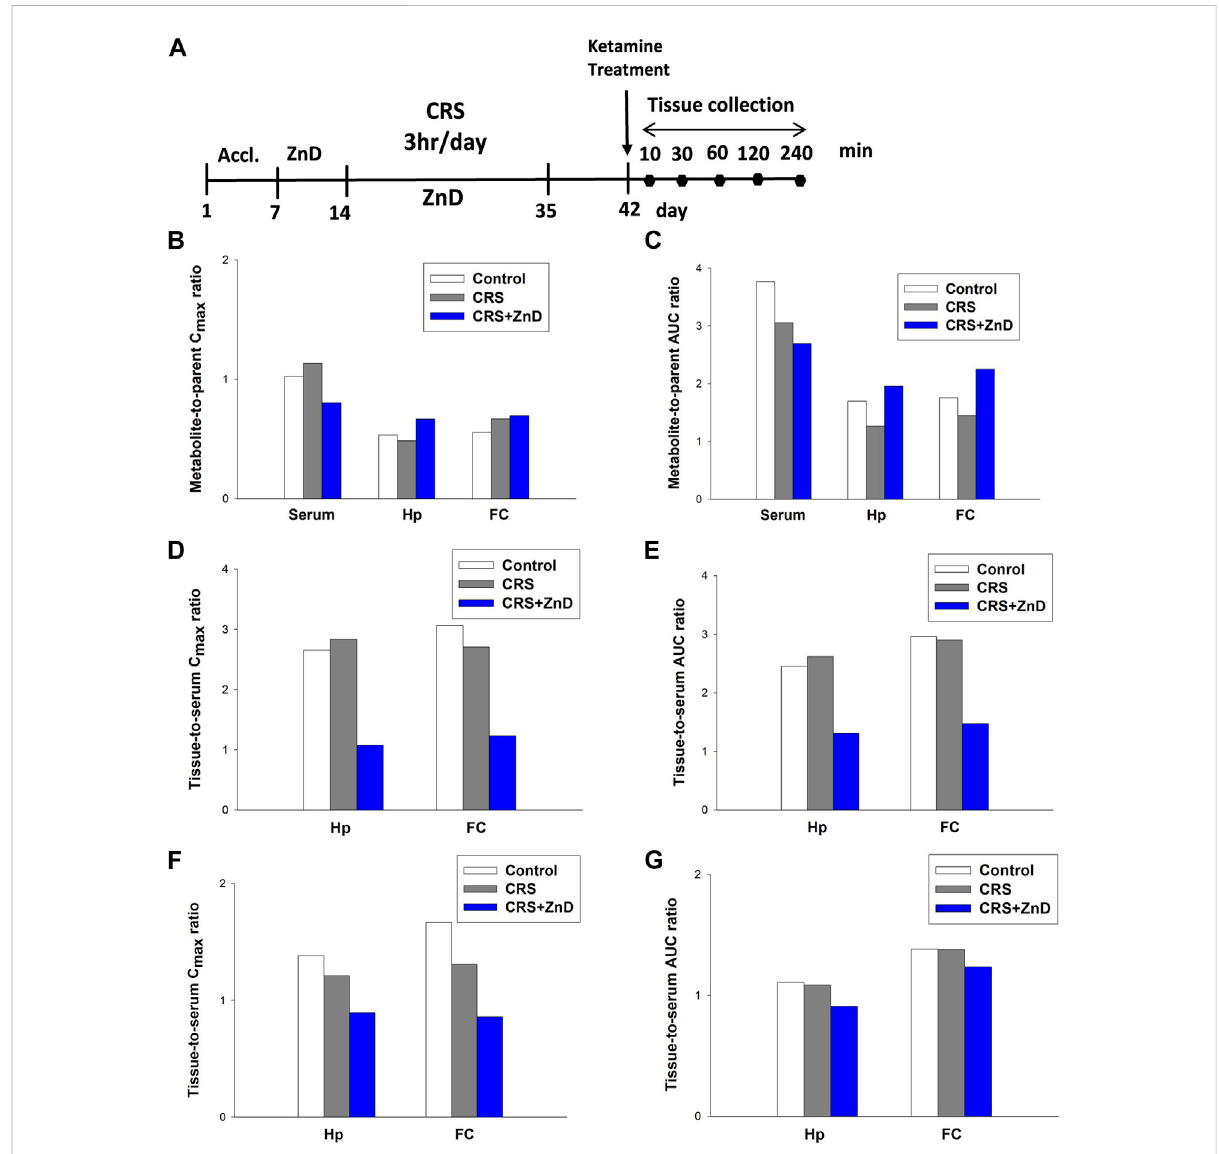
FIGURE 8 (A) Experimental schedule of drug treatment. (B,C) Metabolite-to-parent ratios of maximum concentrations (C max ; left panel) and areas under thecurves(AUCs;rightpanel)inthecontrolandstudygroups. (D,E) Tissue-to-serumratiosofC max (leftpanel)andAUCs(rightpanel)forketaminein the control and study groups. (F,G) Tissue-to-serum C max (left panel) and AUCs (right panel) for (2R,6R;2S,6S)-HNK in the control and study groups. CRS: chronic restraint stress, FC: frontal cortex, Hp: hippocampus, ZnD: zinc de fi cient diet.